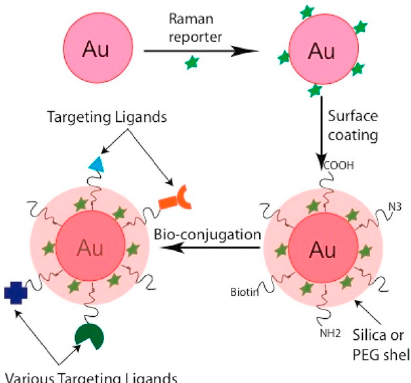
Figure 40. General design of a SERS tag formed by a plasmonic core, a Raman reporter molecule, and a biocompatible layer bearing targeting ligands. Reproduced with permission from Lane et al. [414]. Copyright (2015), the American Chemical Society.